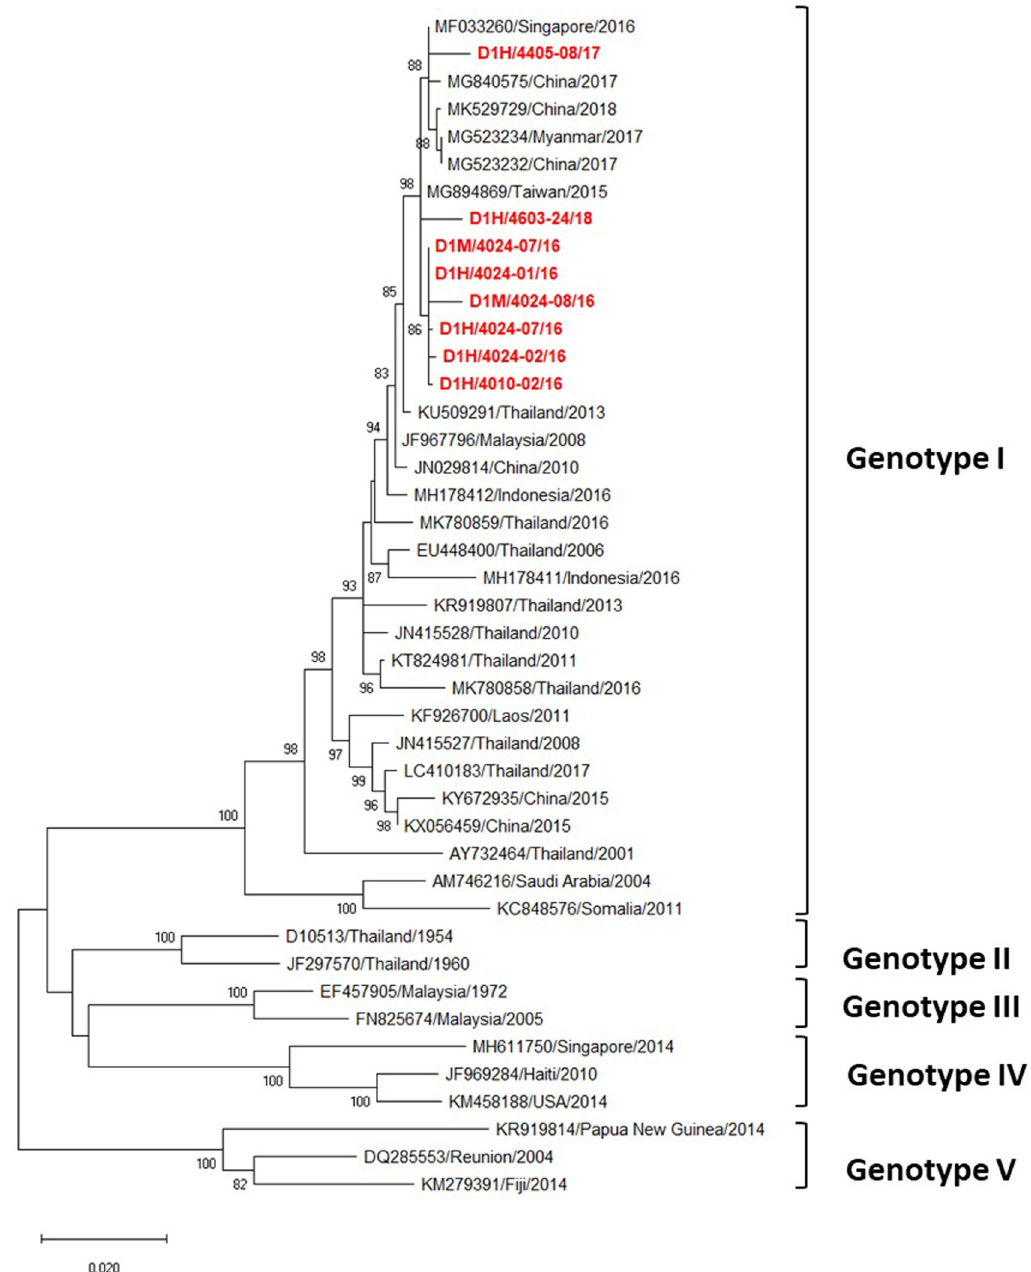
Fig 3. Phylogenetic analysis of DENV-1. Maximum-likelihood tree of the E gene sequences of DENV-1 was generated in the MEGA X program using the TN93 + G model with 1000 bootstrap replications. Bootstrap support values exceeding 80% are shown on branch nodes. The virus names of each sequence retrieved from the NCBI database are labeled as follows: GenBank accession number/country/isolated year. Samples collected in the present study are in red bold font. Annotation on the right denotes DENV